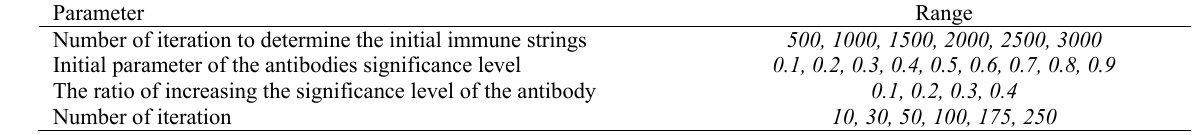
Table 2. The best parameter sets for the proposed AIS algorithm. Parameter Value Number of iteration to determine the initial immune strings 1000 Initial parameter of the antibodies significance level 0.6 The ratio of increasing the significance level of the antibody Number of